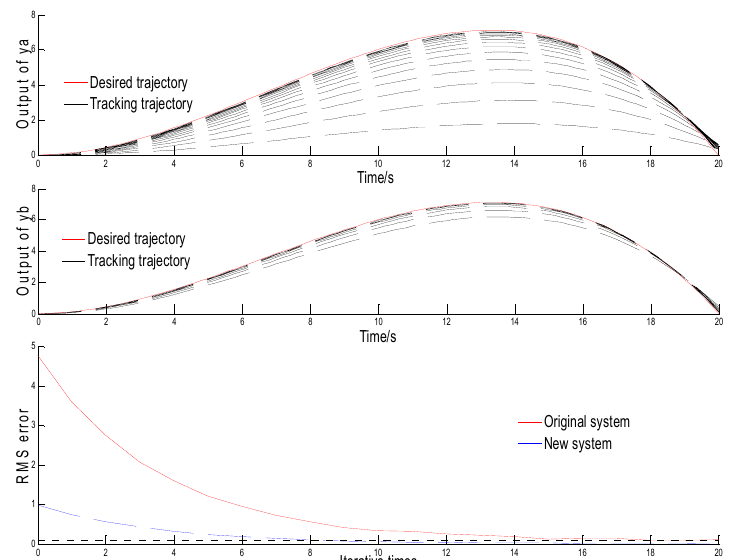
Figure 4. ILC of Recombined Experience Transform.